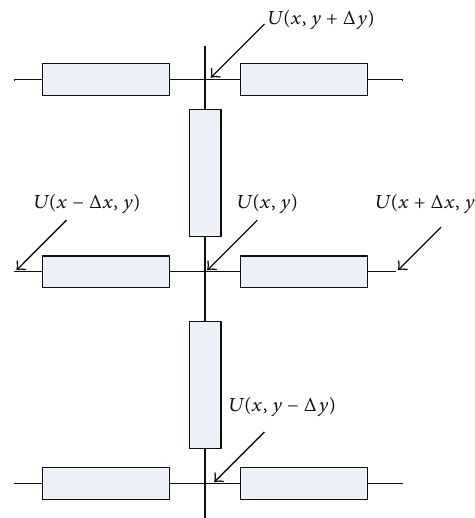
Figure 1: The cartesian grid of the resistive